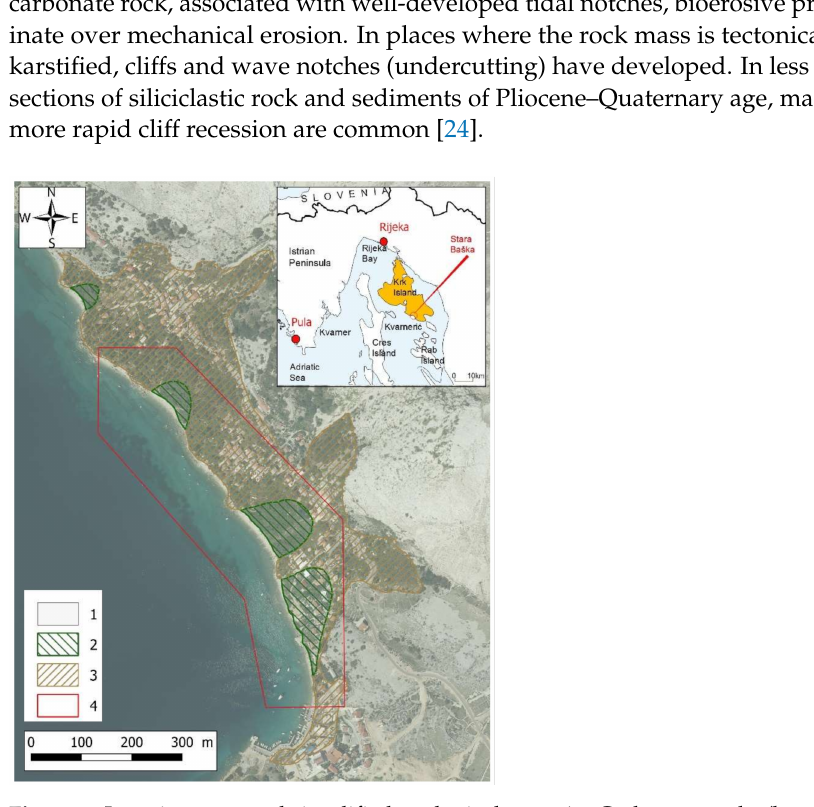
Figure 1. Location map and simplified geological map: 1—Carbonate rocks (bare karst), 2—Flysch rocks (mostly covered by colluvium sediments); 3—Talus breccia; 4—Study